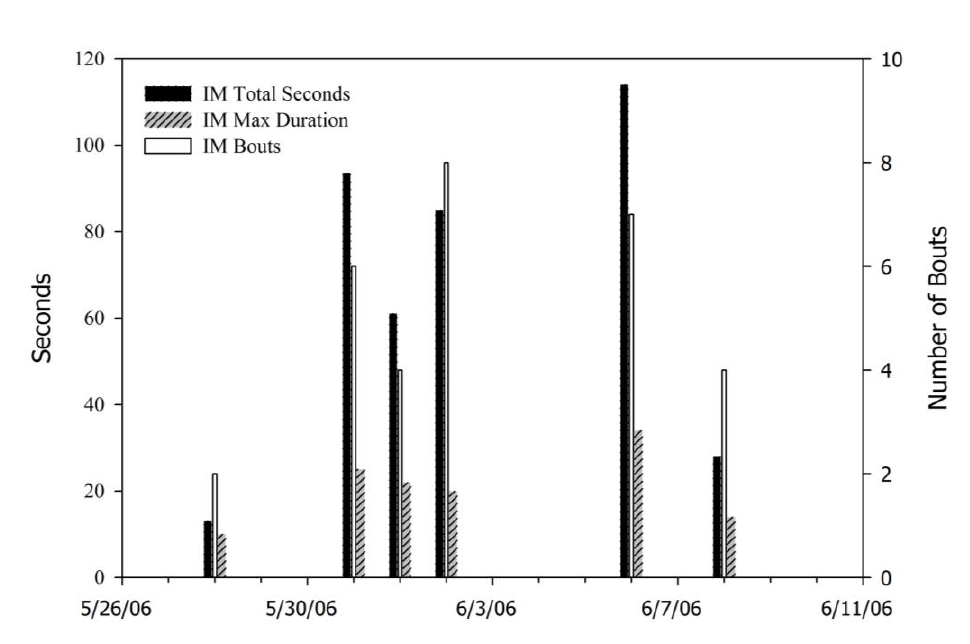
Figure 7 . Animal 1 immobility bouts, total duration in seconds and maximum bout duration in